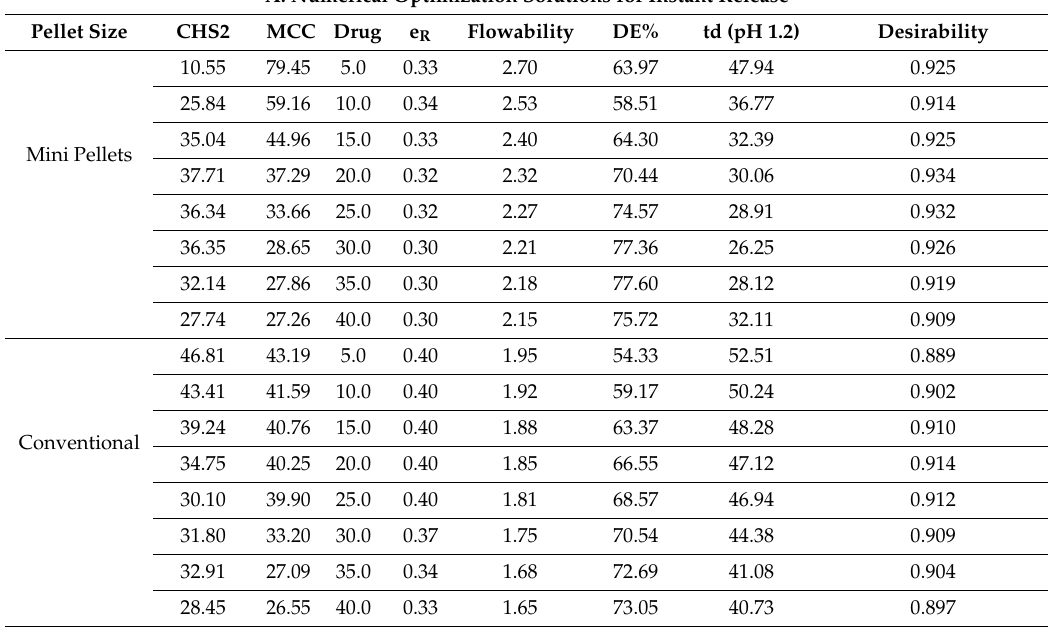
Table 9. Desirability values as computed by numerical optimization for fast (A) and extended release (B) pellets (Criteria for e R , Flowability, DE%, and td are described in the text. Drug content was set to target levels shown in the fourth